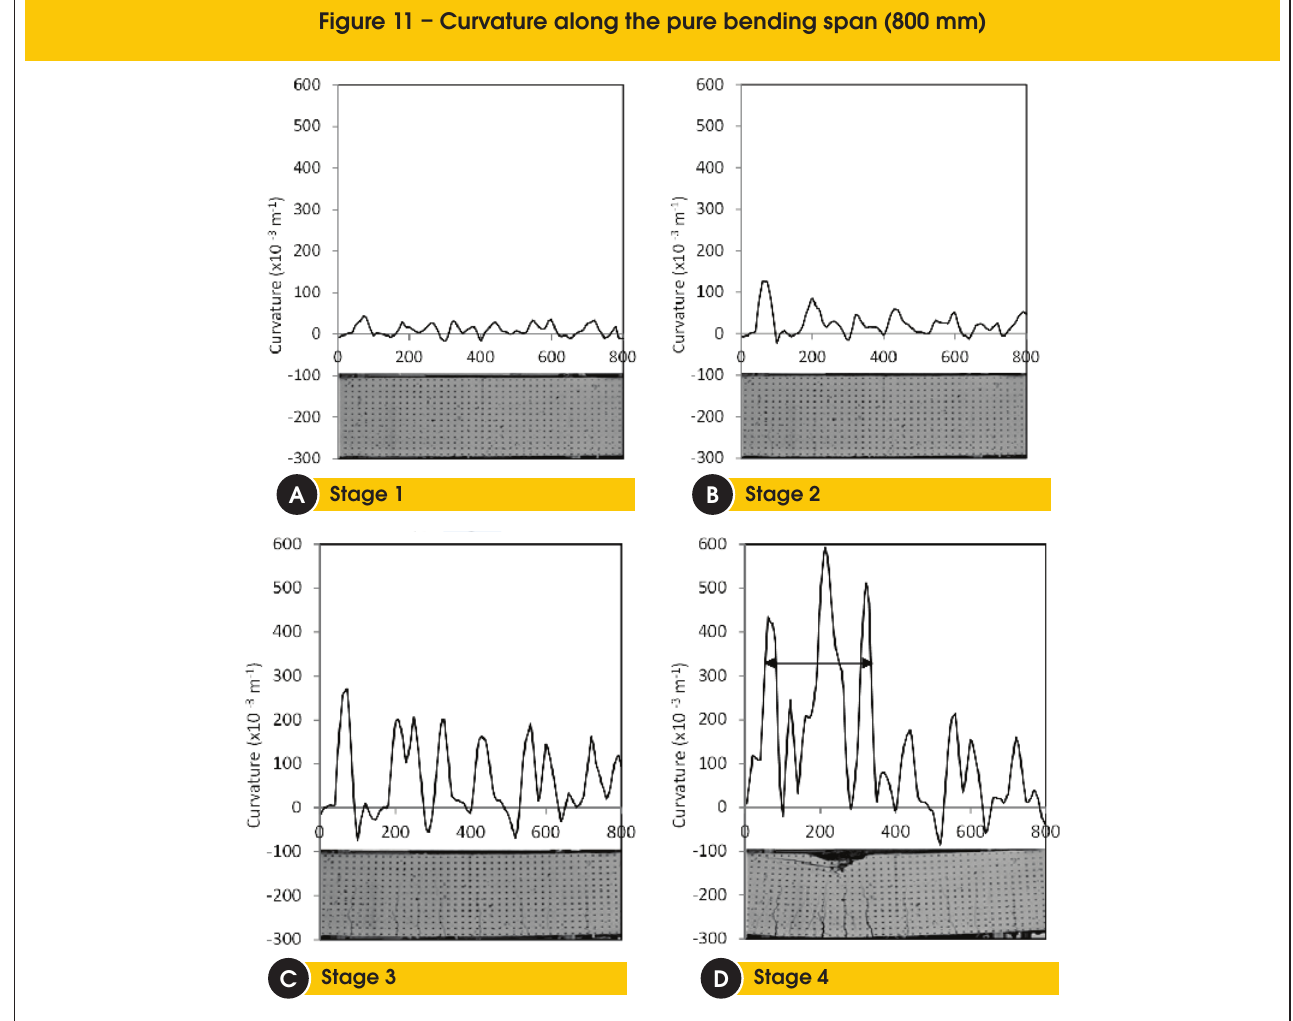
Figure 11 – Curvature along the pure bending span (800